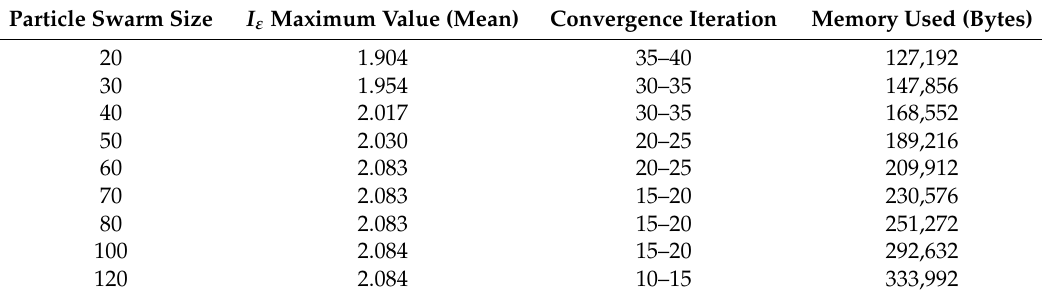
Table 2. Maximum I ε with different particle swarm